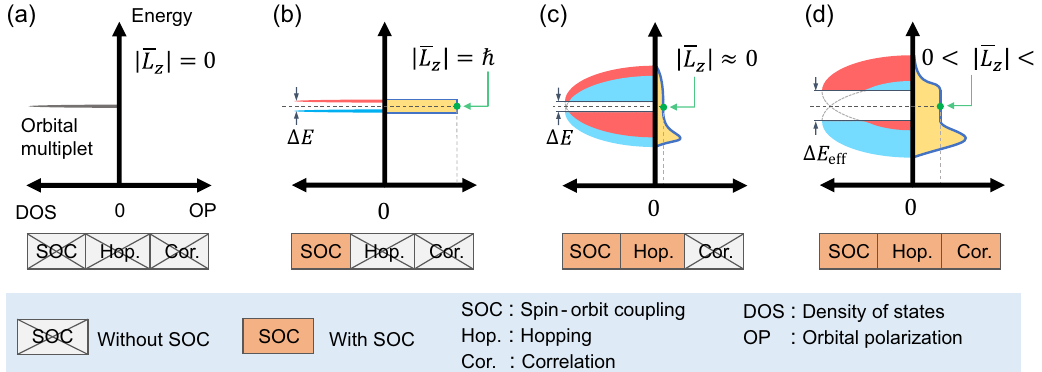
Fig. 1 Schematic of boosting the effective SOC by correlation. The density of states (DOS, the left part of the horizontal axis) and orbital polarization (OP, the right part of the horizontal axis) of the orbital doublet in single-ion limit ( a , b ) and periodic solids ( c , d ) considering the effects of SOC, inter-ion hopping and correlation. a Without SOC, the doubly degenerated orbital multiplet has quenched orbital angular momentum, (cid:2) L z degenerated levels (denoted by red and blue colors) with an energy gap, Δ E , and orbital polarization (cid:2) L z extends the energy levels into energy bands, leaving a tiny (cid:2) L z because the SOC is typically signi fi cantly weaker than the inter-ion hopping. d Competition between the delocalized hopping and the on-site correlation effect signi fi cantly enhances (cid:2) L z self-consistently, as well as the SOC effect and the energy